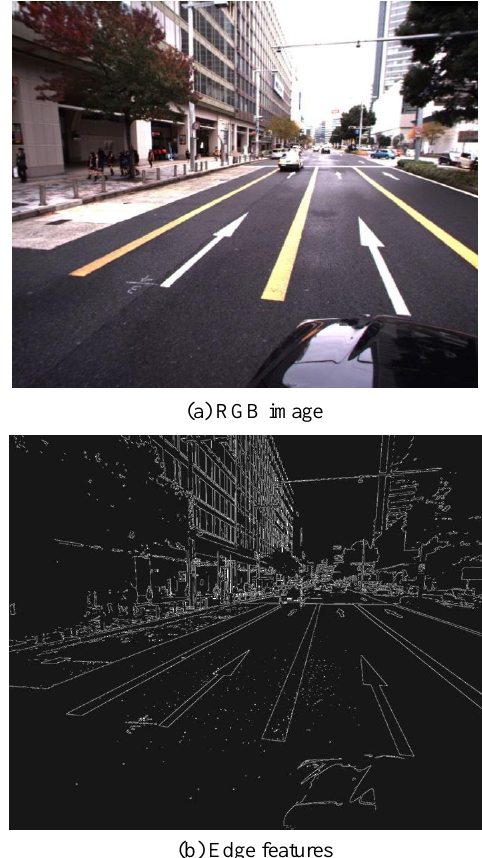
Figure 12. Connection of edge features